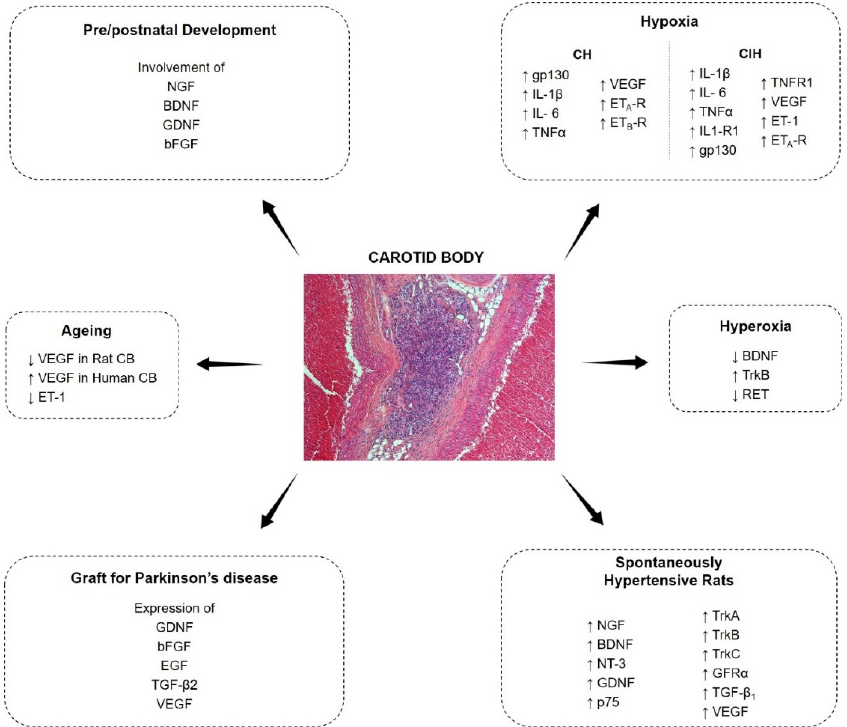
Figure 1. Expression and modulation of growth factors in the carotid body.